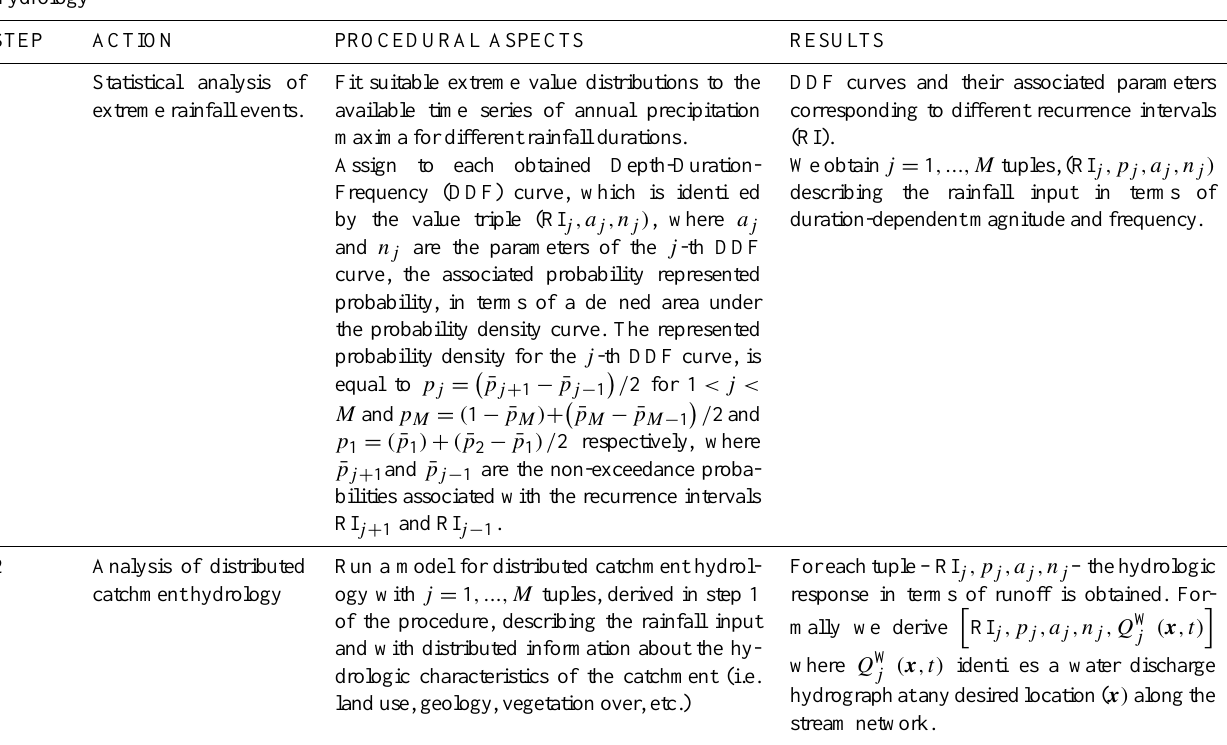
Table 1. Main steps of the hydrological